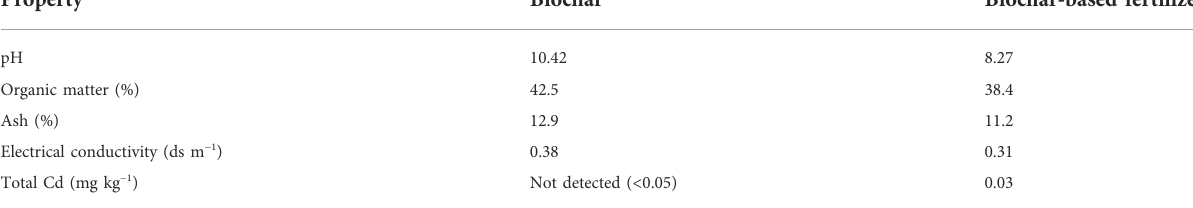
TABLE 1 Characteristics of biochar and biochar-based fertilizer.